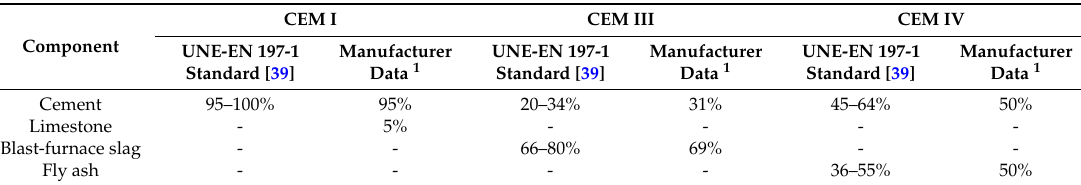
Table 1. Components of the commercial cements